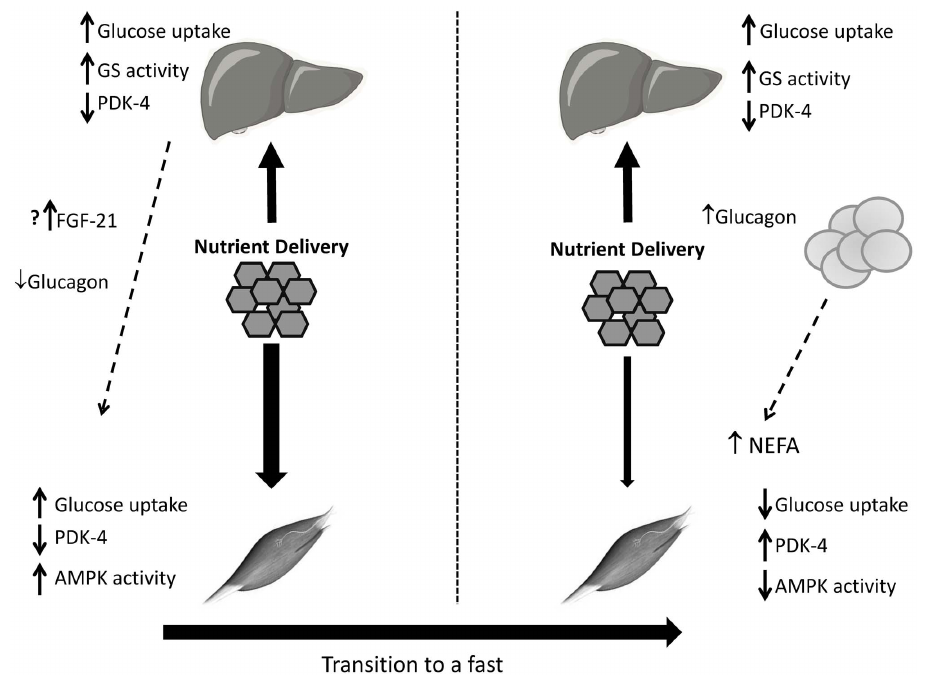
Figure 5. Schema representing the hepatic and muscle response to sustained nutrient delivery and the response to a physiologic fast. In response to sustained glucose availability the capacity of both the liver and muscle to oxidize and store carbohydrate is augmented. This is accompanied by low rates of lipolysis, glucagon secretion and augmented FGF-21. In response to a physiologic overnight fast glucagon and lipolysis increase and FGF-21 decreases which suppress the capacity of the muscle to oxidize and store carbohydrate, while having limited effects on the capacity of the liver to store and oxidize glucose.